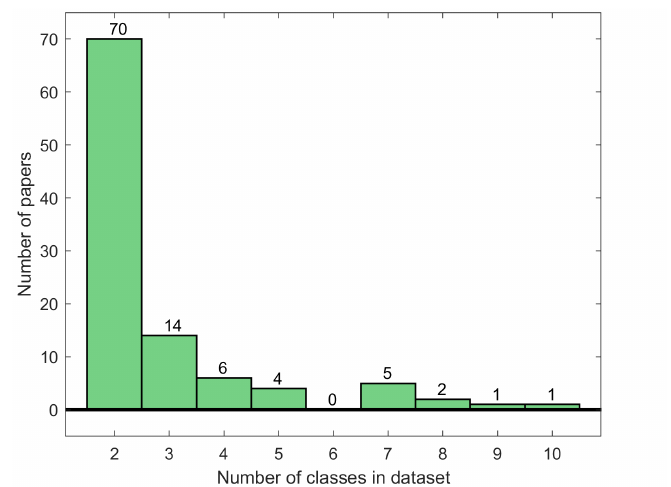
Figure 6. Number of classes used for skin disease